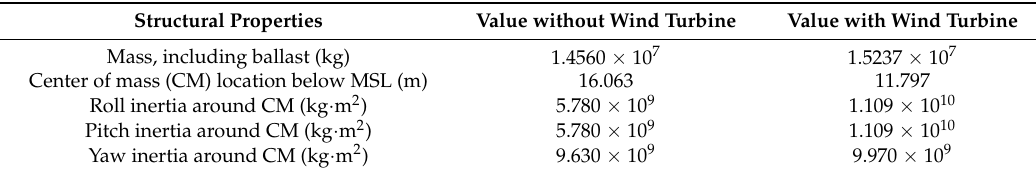
Table 1. Platform structural properties.